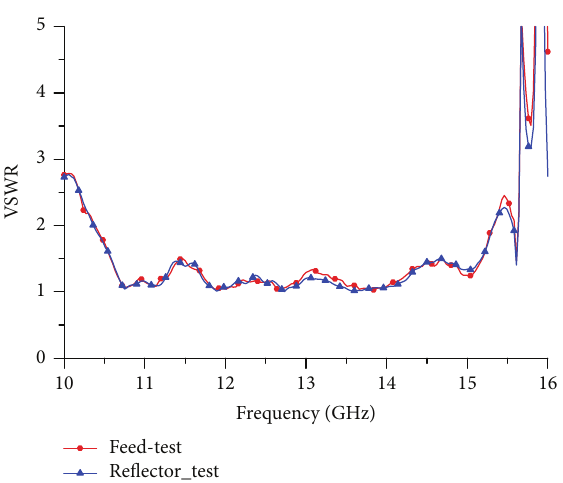
Figure 11: Test VSWR of the feed and reflector.